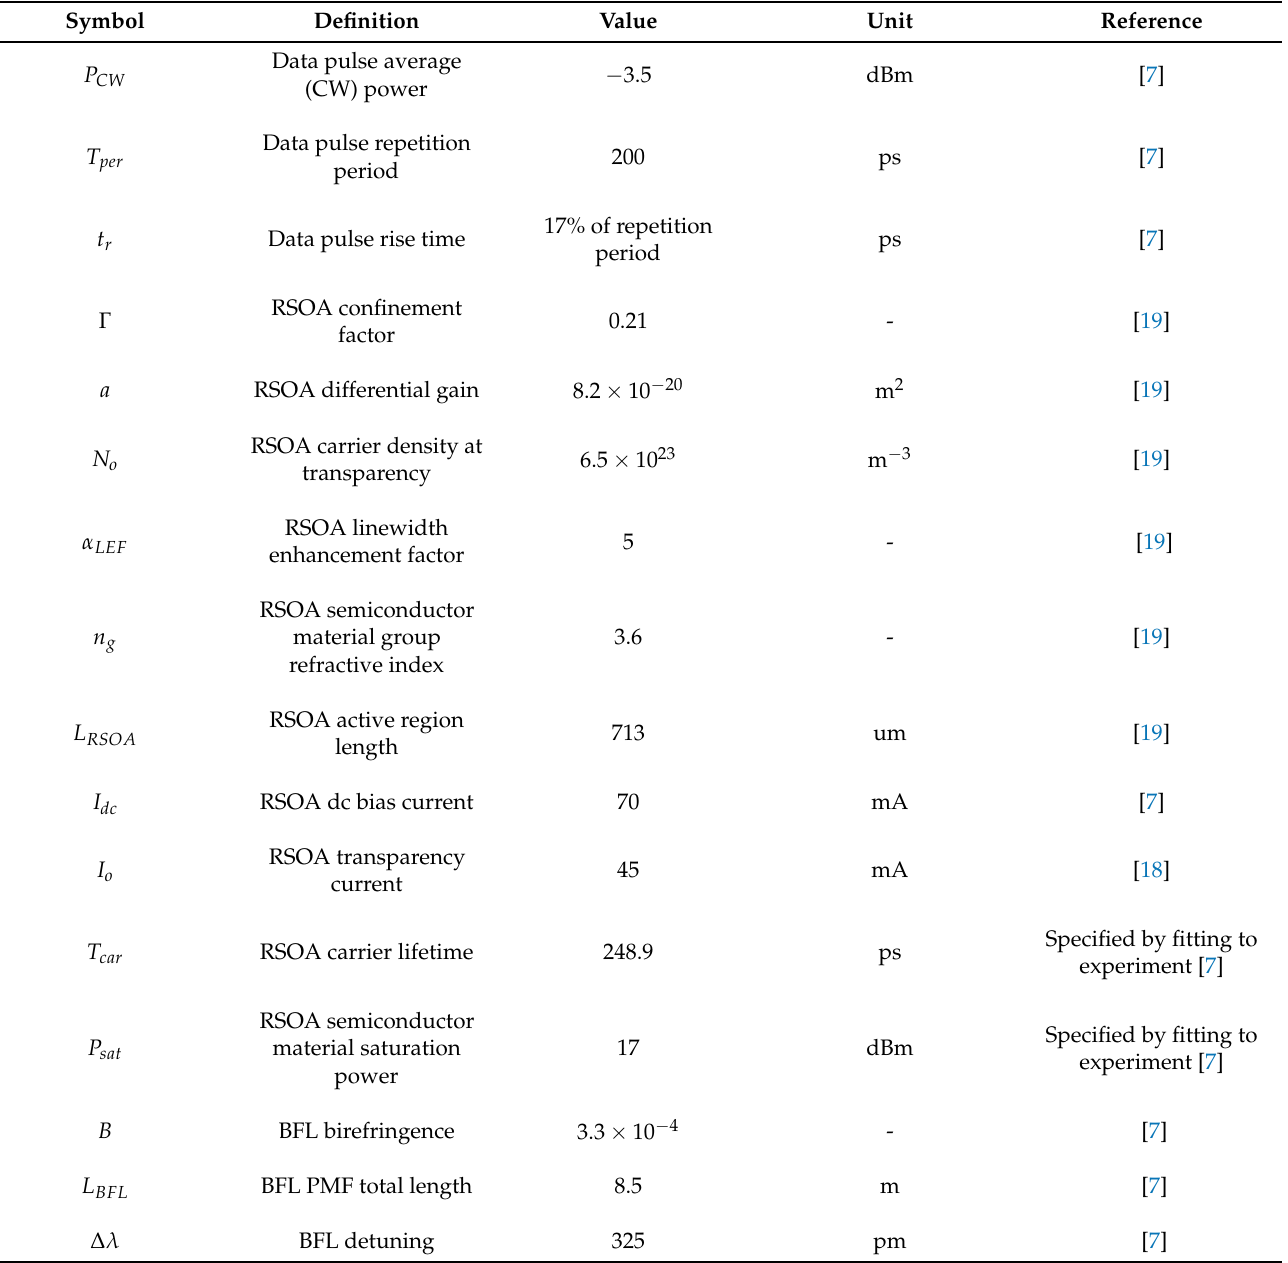
Table 1. Simulation parameters default